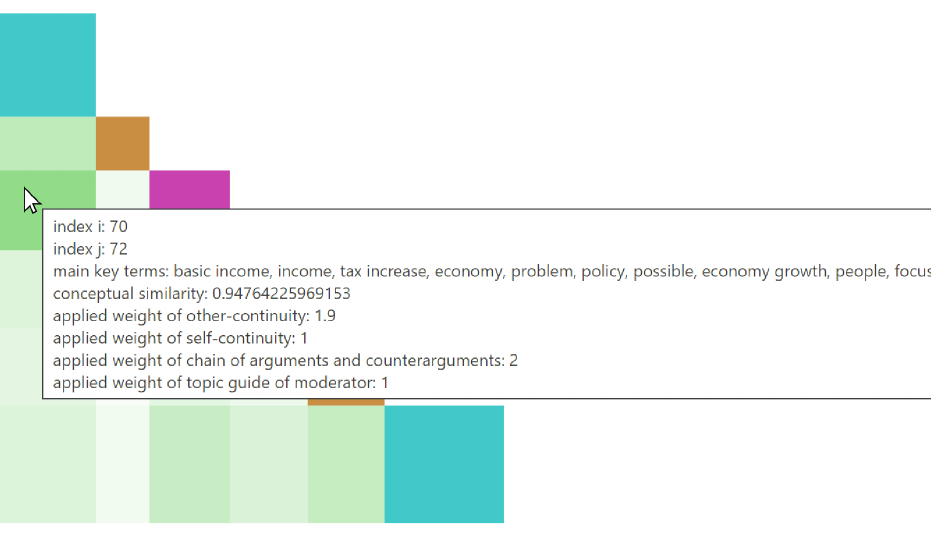
Figure 19. Details of conceptual similarity when the user mouseovers the